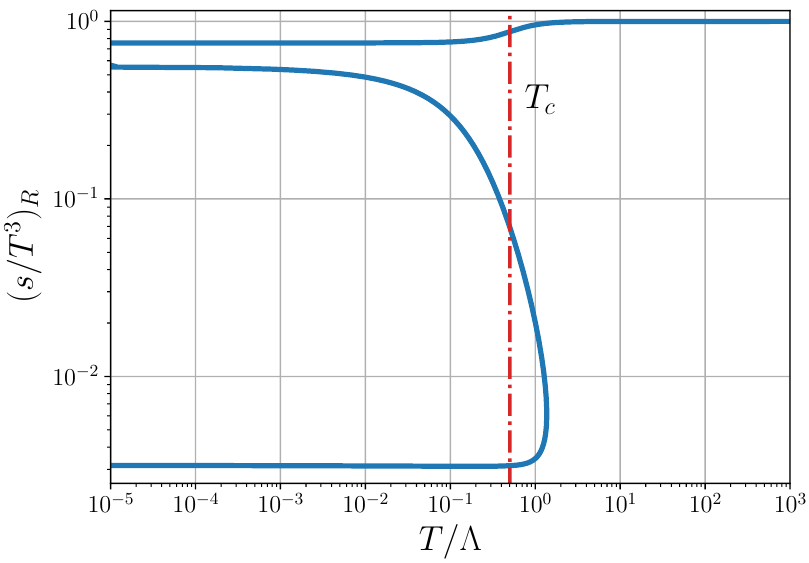
Figure 15 . Rescaled entropy versus temperature graph for φ M ’ 0 . 5797 and φ Q = 10 . 0 , with critical temperature T c / Λ ≈ 0 . 499